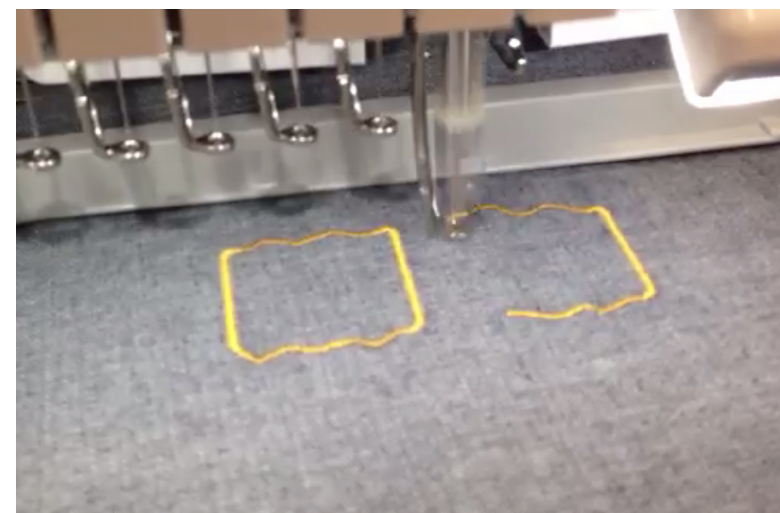
Figure 9. Embroidery machine creating FSS